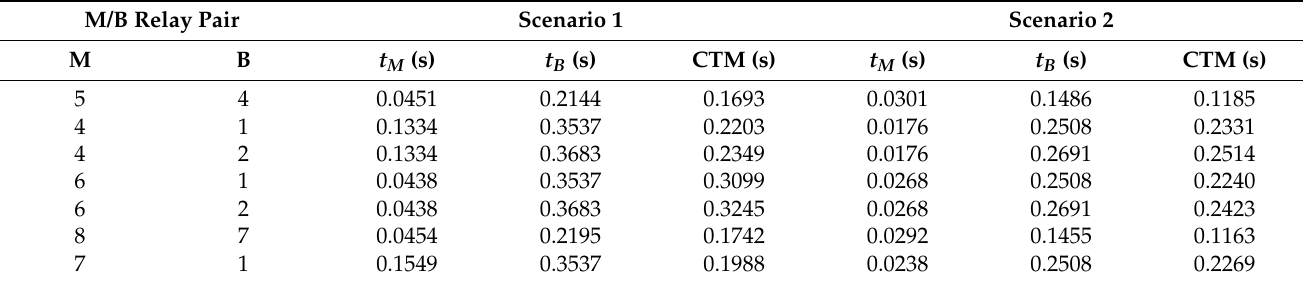
Table 17. Coordination check of Test Model